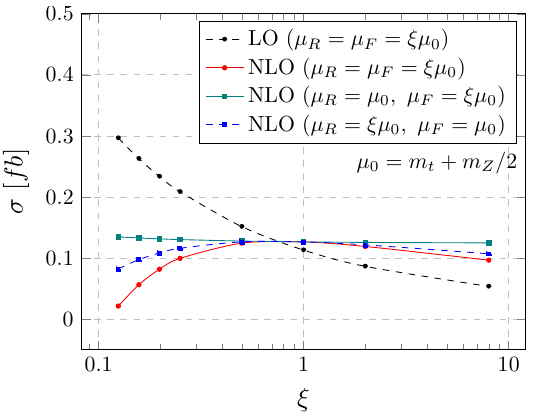
Figure 3 . Scale dependence of the LO and NLO integrated cross section for the pp e + (cid:23) e (cid:22) (cid:0) (cid:22) (cid:23) (cid:22) b (cid:22) b (cid:23) (cid:28) (cid:22) (cid:23) (cid:28) + X process at the LHC run II with p s = 13 TeV. Renormalisation and fac- torisation scales are set to (cid:22) R = (cid:22) F = (cid:24)(cid:22) 0 where (cid:22) 0 = m t + m Z = 2 and (cid:24) and NLO CT14 PDF sets are employed. Also shown is the variation of (cid:22) R with (cid:12)xed (cid:22) F and the variation of (cid:22) F with (cid:12)xed (cid:22) R . Scale Choice